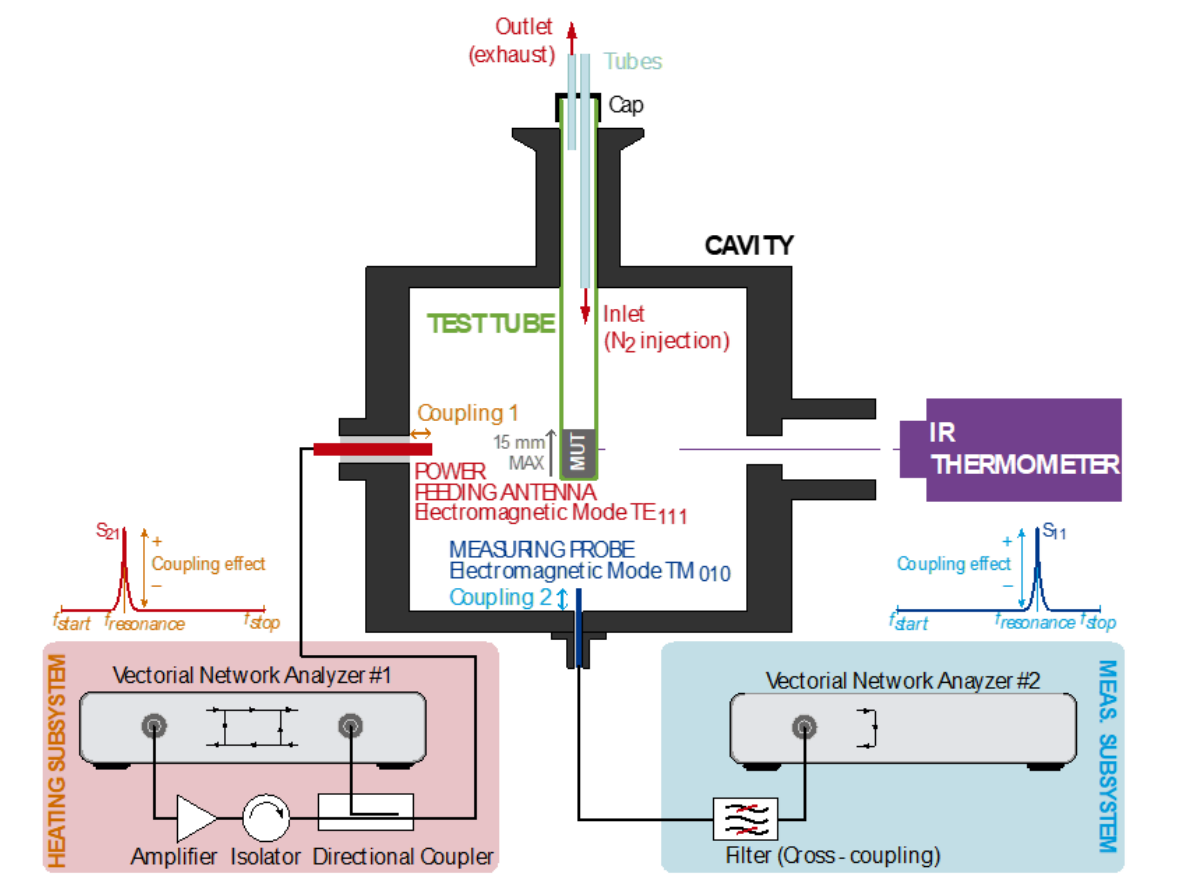
Figure 1. Sketch of the test